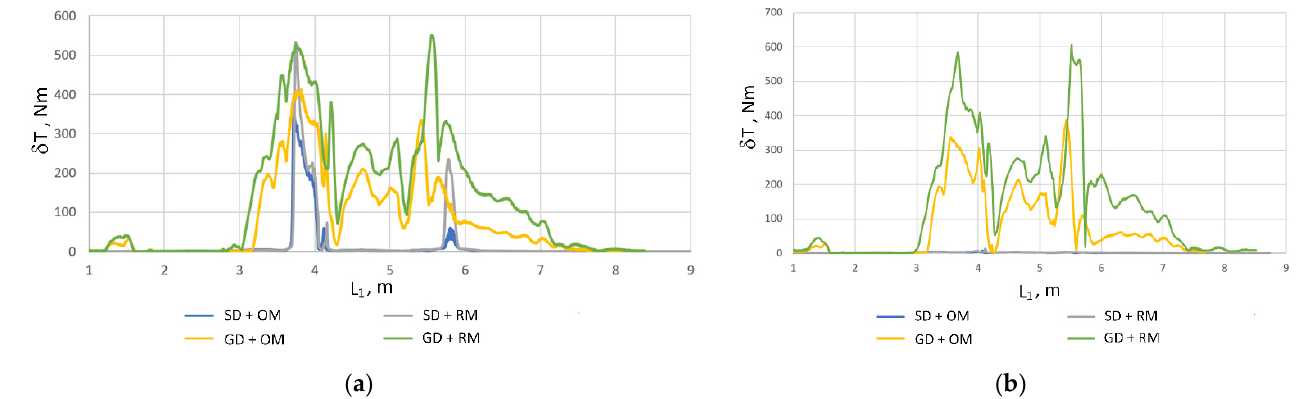
Figure 18. Changes in the difference in driving torques on the road wheels during the simulation when the vehicle model was driven through the ditch at the maximum value of the coefficient of adhesion φ = 0.3 ( a ) oraz φ = 0.7 ( b ): GD—gear-type flow divider, SD—spool-type flow divider,